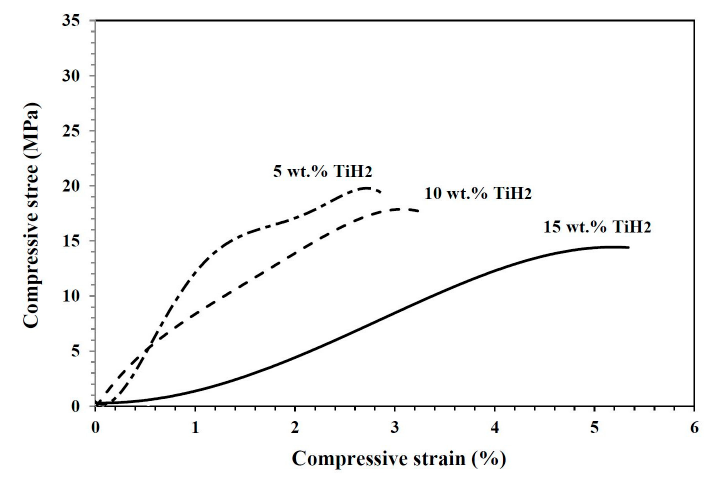
Figure 10. Compressive behavior of pure Ti foam. Table 1. Porosity, relative density, compressive strength and energy absorption of Ti matrix foams.